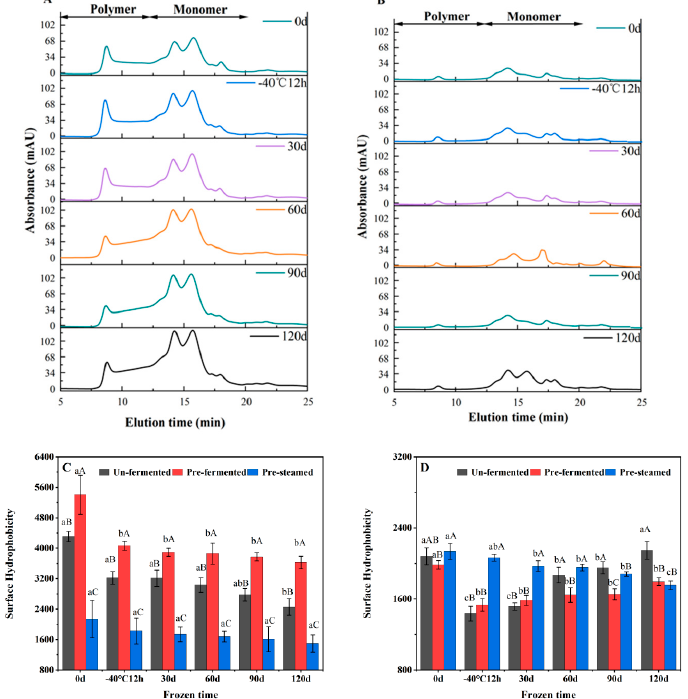
Figure 6. Representative SE-HPLC profile of unfermented ( A ) and par-steamed frozen dough buns( B ), and the variation of surface hydrophobicity of gluten proteins in doughs ( C ) and steamed buns ( D ) during frozen storage. Data with different lowercase and uppercase letters indicate the significant differences among the frozen doughs with different storage times and different processing techniques, respectively ( p < 0.05). Table 4. Effects of frozen storage time on protein molecular weight distribution after thawing and steaming of frozen dough buns with different processes.